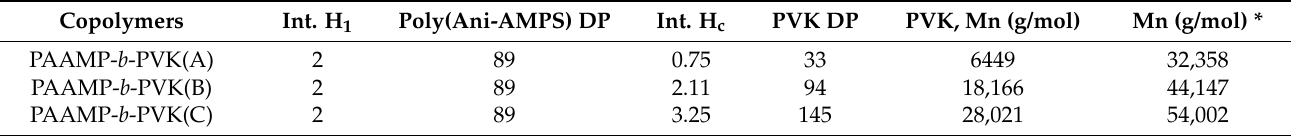
Table 2. Proton integration (int.) of H 1 and H c for molecular weight calculation of the PAAMP- b -PVK.